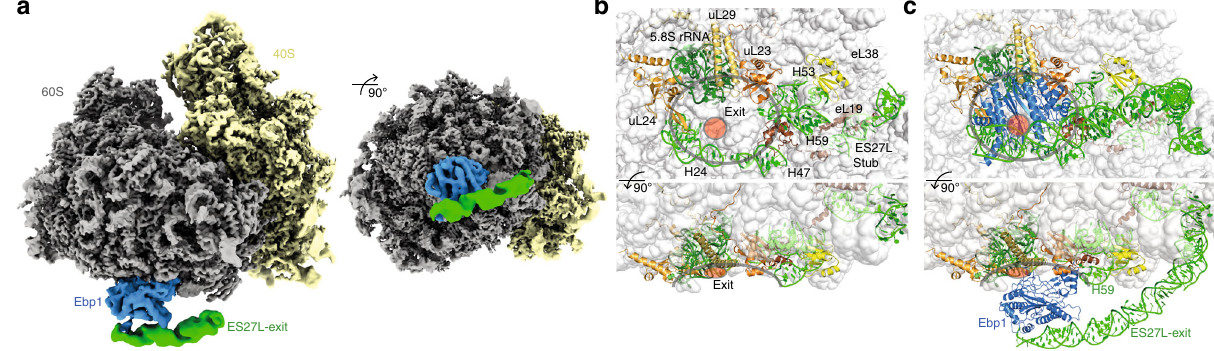
Fig. 1 Ebp1 binds to the ribosomal tunnel exit and ES27L. a Composite cryo-EM reconstruction of the Ebp1 – ribosome complex after 3-body re fi nement. The ribosomal large (gray) and small (yellow) subunits, Ebp1 (blue) and ES27L (green) are depicted. b , c Overall structures of the vacant human ribosome (PDB ID: 6EK0) and the Ebp1 – ribosome complex. Cartoon representations for ribosomal elements involved in Ebp1 binding (rRNA: green; ribosomal proteins: yellow, orange, brown) are shown for the vacant ribosome ( b ) and in complex with Ebp1 (blue, c ). Ribosome components not engaged in Ebp1 interaction are shown in a transparent surface representation. ES27L (green) is only visible as stub without any associated factor and is fi xed in the exit position upon Ebp1 binding. The ribosomal tunnel exit (red circle) and the inner ring of ribosomal components around the tunnel exit (gray outline) are indicated. Views are the same as in ( a ) with panels in the upper row looking straight down onto the ribosomal tunnel exit, while panels in the lower row are rotated by